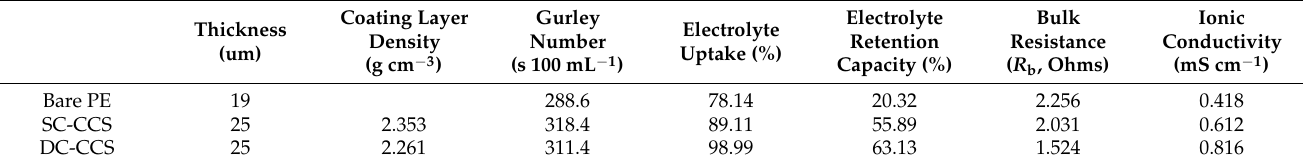
Table 2. Physical properties of bare PE, SC-CCSs, and DC-CCSs.